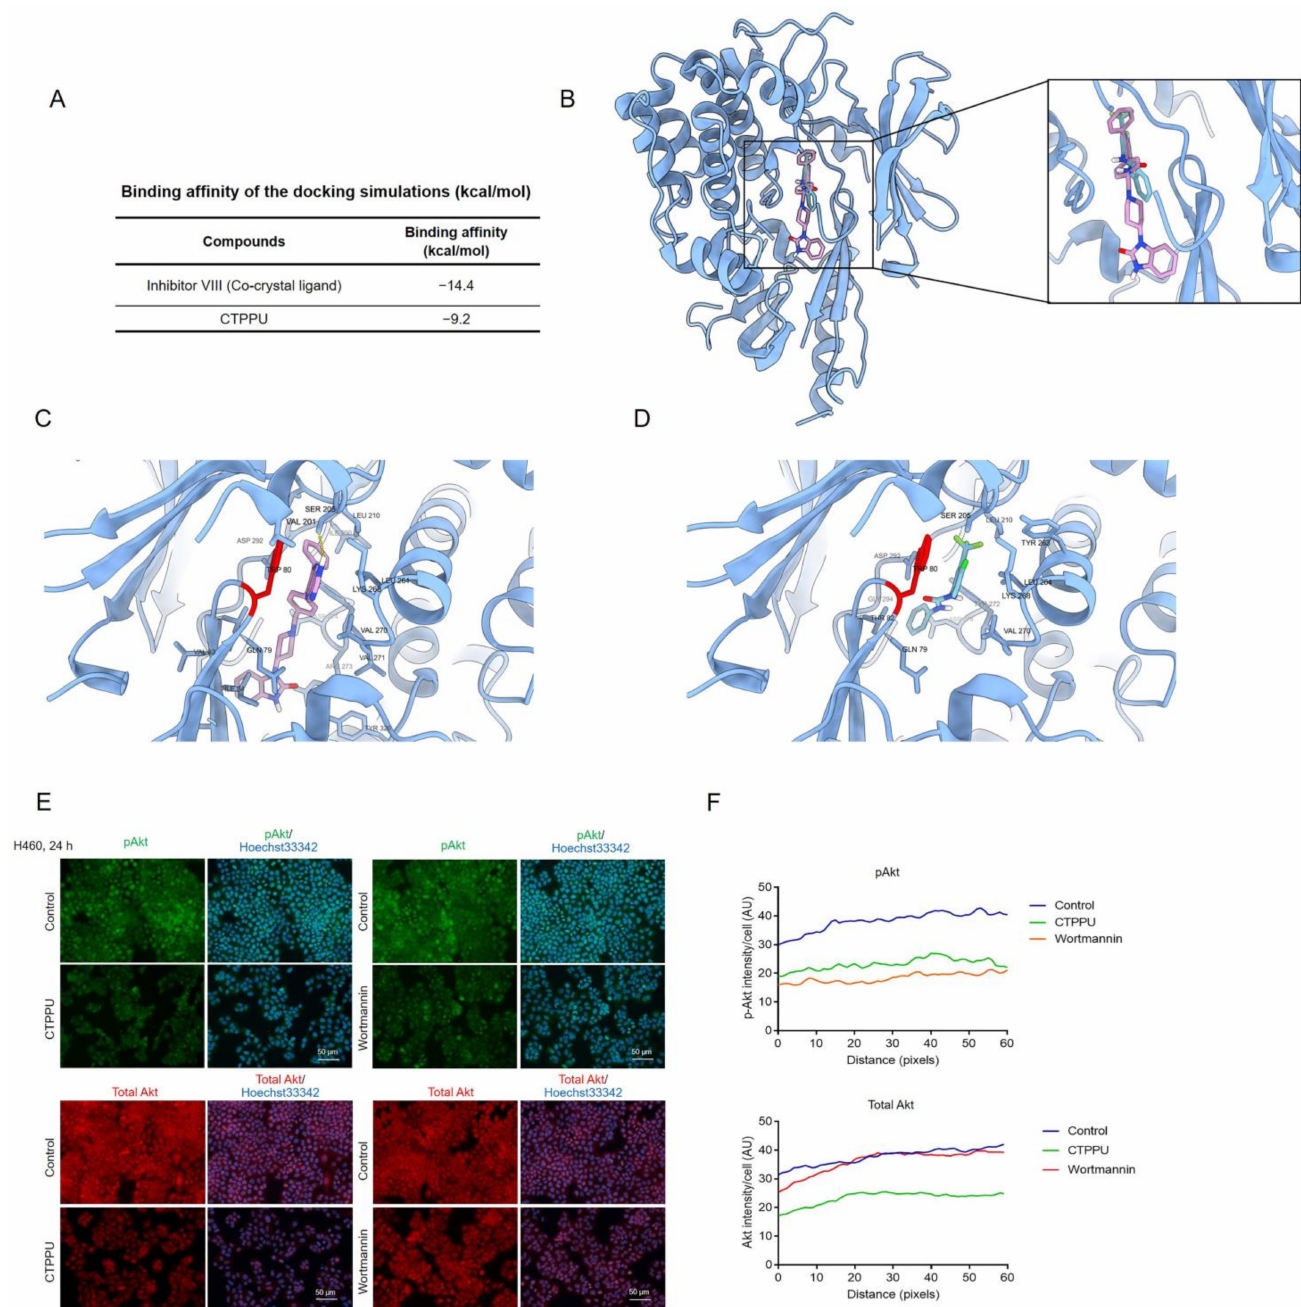
Figure 7. The effect of CTPPU decreased Akt protein expression and a docked model depicting the interaction of CTPPU with the Akt protein. ( A ) The binding affinities of CTPPU against the Akt-1. Docking interaction profile of Akt-1 inhibitors: ( B ) Binding of Inhibitor VIII and CTPPU to the Akt-1 binding site, ( C ) Binding interaction of Inhibitor VIII-Akt-1 complex, ( D ) Binding interaction of CTPPU-Akt-1 complex. ( E ) The expression levels p-Akt and Total Akt were determined by immunofluorescence analysis after CTPPU treatment for 24 h compared to wortmannin. All images were captured at 200 × magnification. Scale bars, 50 µ m. ( F ) Histogram showed the quantitative results of E. The fluorescence intensity was analyzed using ImageJ